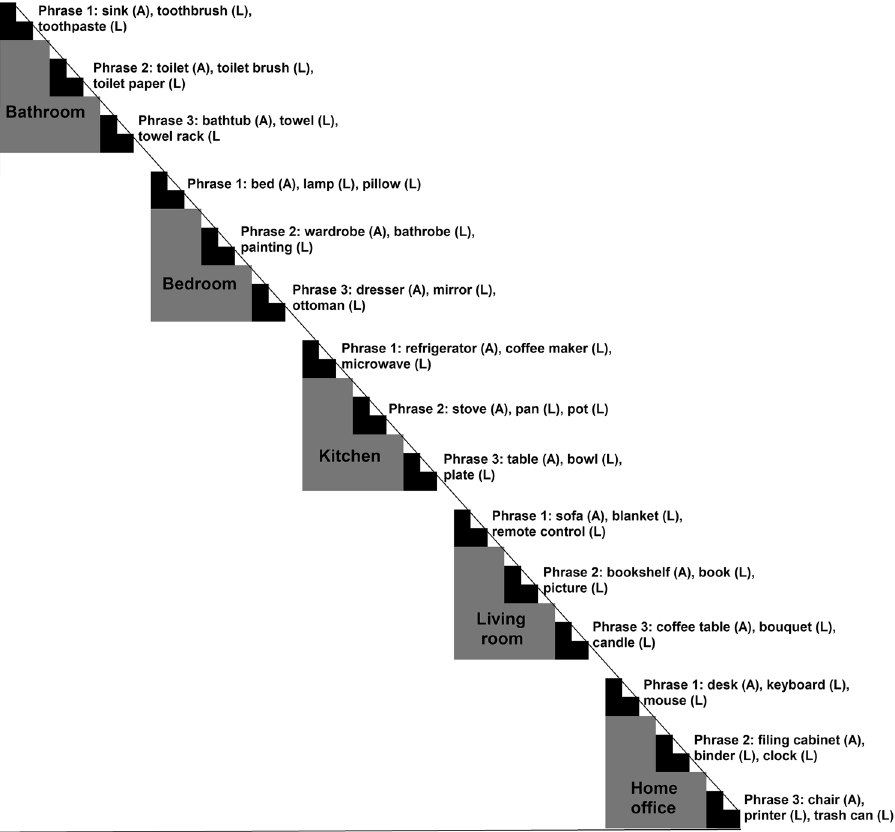
Figure 2. One half of a symmetric Representational Dissimilarity Matrix (RDM) showing the organization of individual object pairs based on the a priori hierarchical organization. Gray and black portions of the triangle represent pairs of objects assigned to the same scene category, while black portions represent pairs of objects assigned to the same phrase within the scene. Scene category labels and composition of the phrases are also reported, the letter (A) indicates an anchor object, the letter (L) indicates local objects. The remaining white portion of the triangle represents pairs of objects that are assigned to different scenes. This order of objects is maintained in the RDMs and used to represent different levels of the hierarchical models (see Fig.